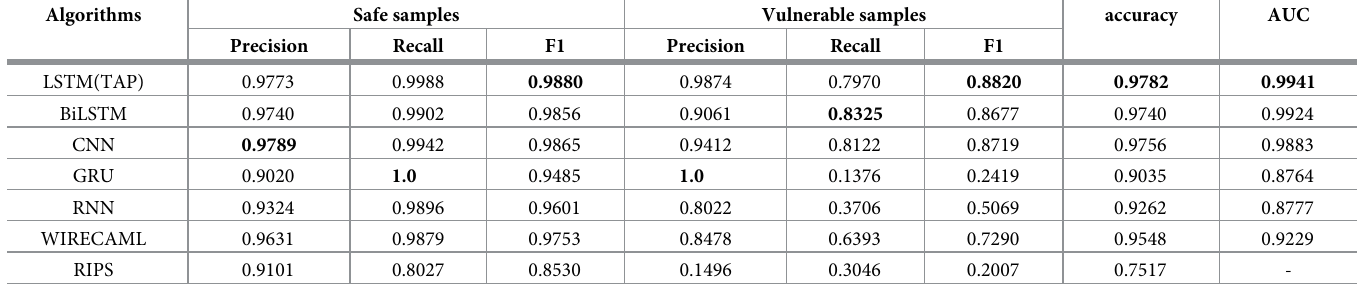
Table 6. Evaluation criteria of binary classification